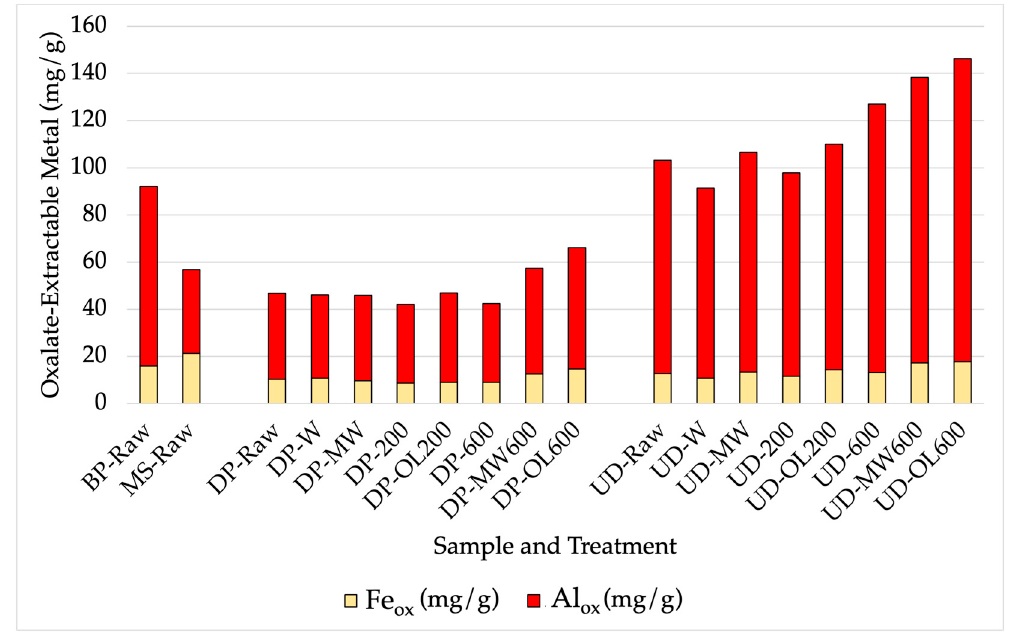
Figure 2. Concentration of oxalate-extractable Al (Al ox ) and Fe (Fe ox ) in the raw and experimentally treated DWTRs. Table 3. Physiochemical data reduction parameters from BET adsorption/desorption tests with N 2